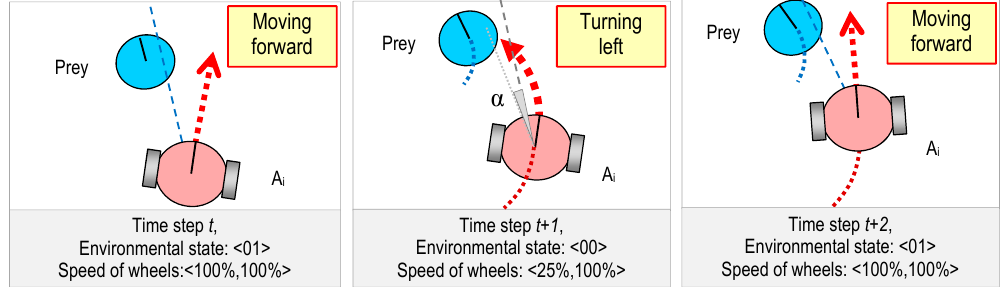
Figure 8. Reliable tracking of the prey by a predator Ai.